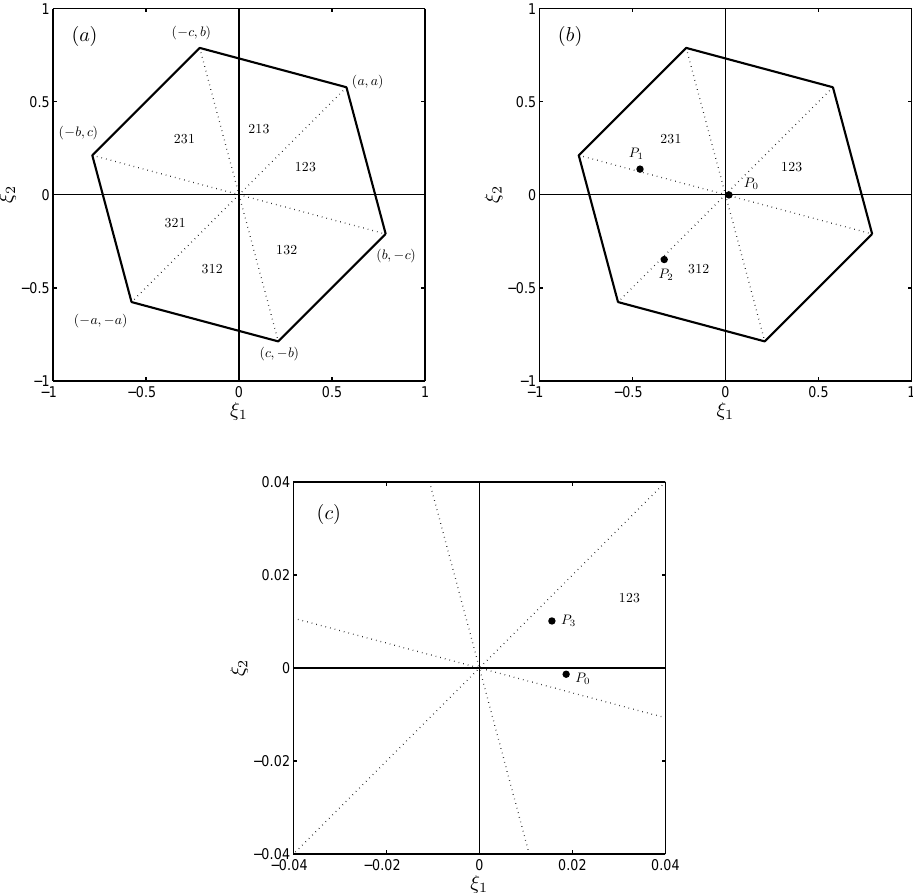
Figure 2. Evolution of a system made up of three faults ( n = 3), represented in the state space: (a) the hexagon H , defined in Sect. 7, with Figure 2. Case n = 3 : (a) The hexagon H with its subsets labeled by the associated permutation; (b) its subsets labelled by the associated permutations; (b) states of the system during a seismic sequence: P 0 is the initial state; P i ( i = 1 , 2 , 3) States of the system during a seismic sequence: each point belongs to the subset labeled by the associated is the state after the i th event of the sequence; (c) magnification of H showing the initial and final states P 0 and P 3 permutation; (c) magnification of H showing the initial and final states.